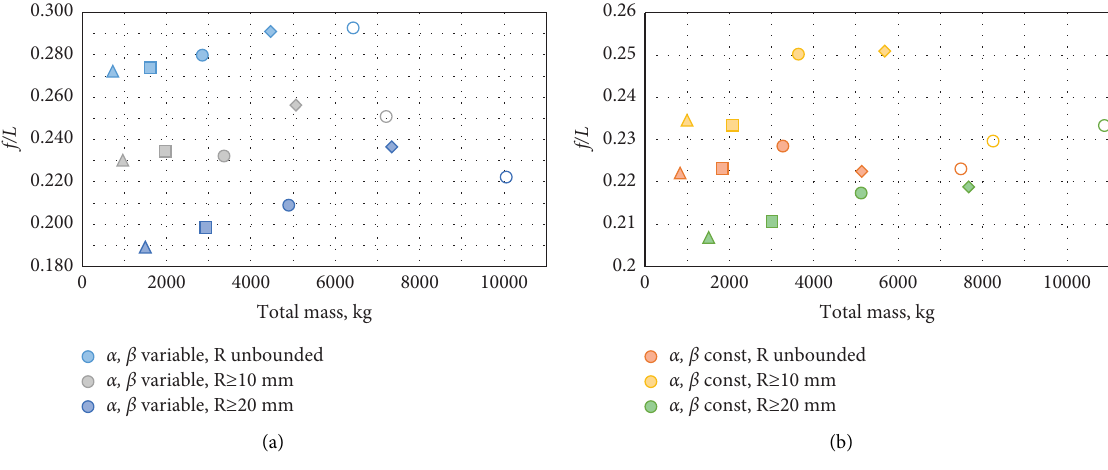
Figure 7: Average optimal values of f / L for all spans. (a) α , β variable. (b) α , β